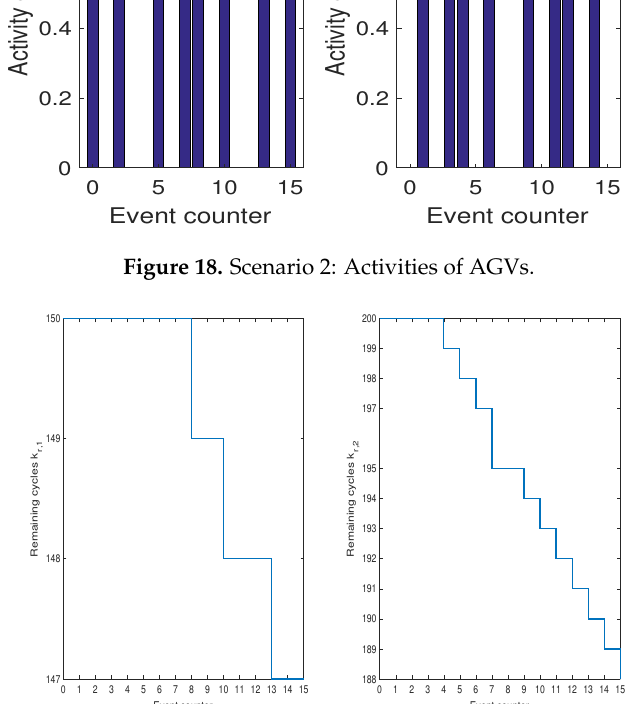
Figure 19. Scenario 3: SOH of AGVs expressed by the remaining cycles k f , i